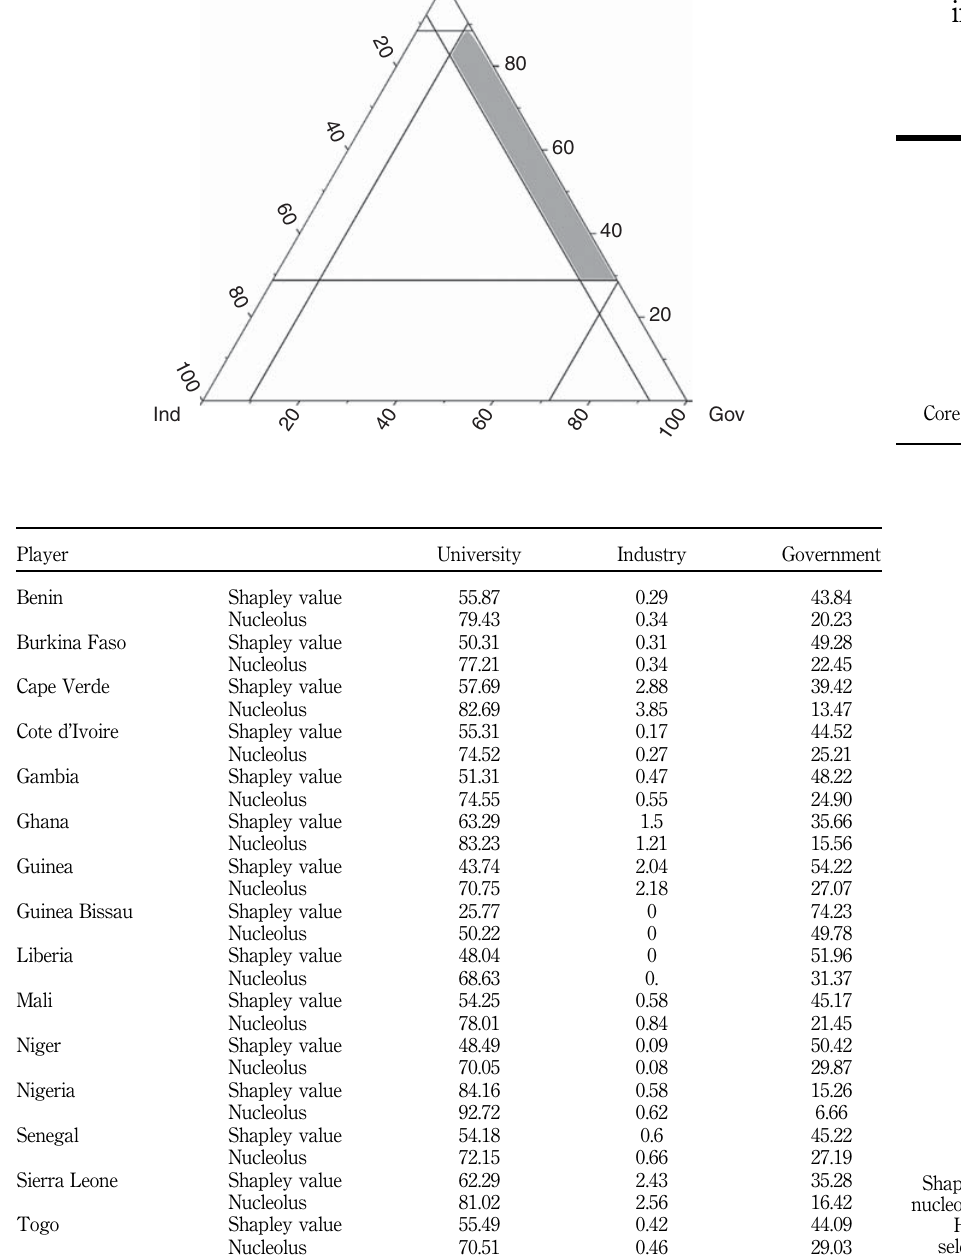
Table IV. Shapley values and nucleoli of the Triple Helix system of selected